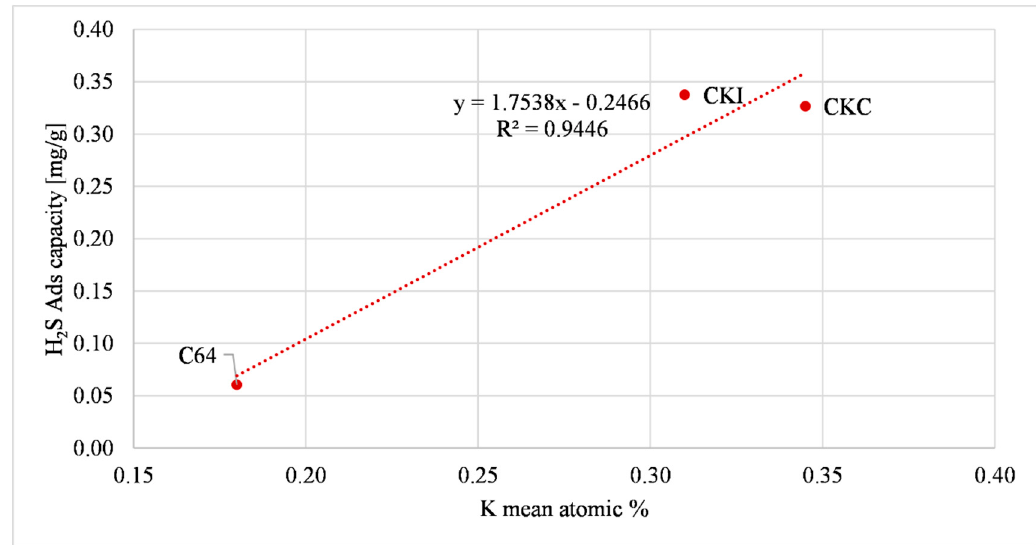
Figure 8. Potassium oxide effect on H 2 S adsorption (AC as received).